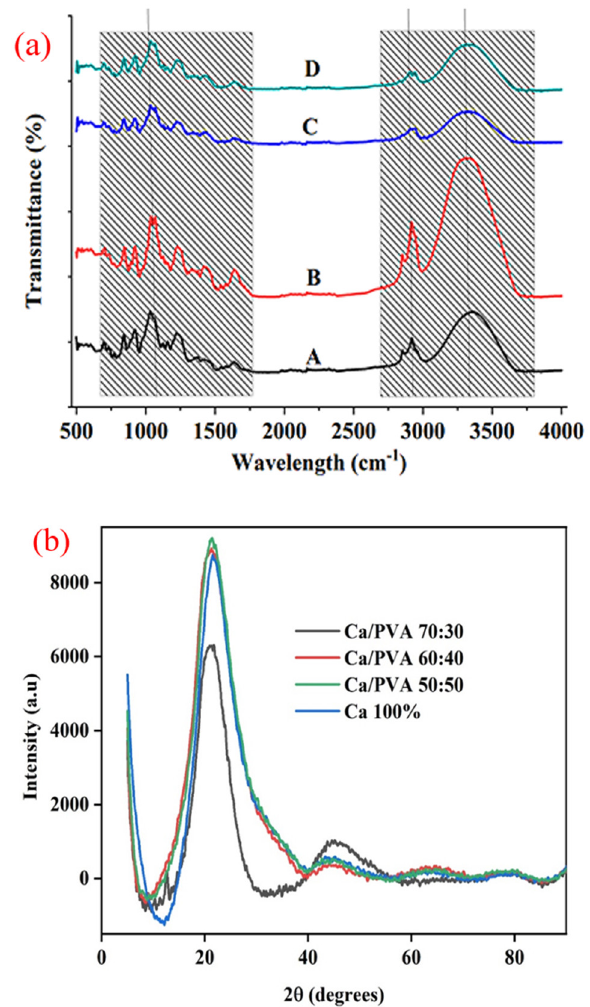
Figure 1. ( a ) FTIR spectra of (A) Ca/PVA 50:50, (B) Ca/PVA 60:40, (C) Ca/PVA 70:30, and (D) Ca. ( b ) XRD diffraction patterns of Ca/P composites. ( b ) XRD diffraction patterns of Ca/P